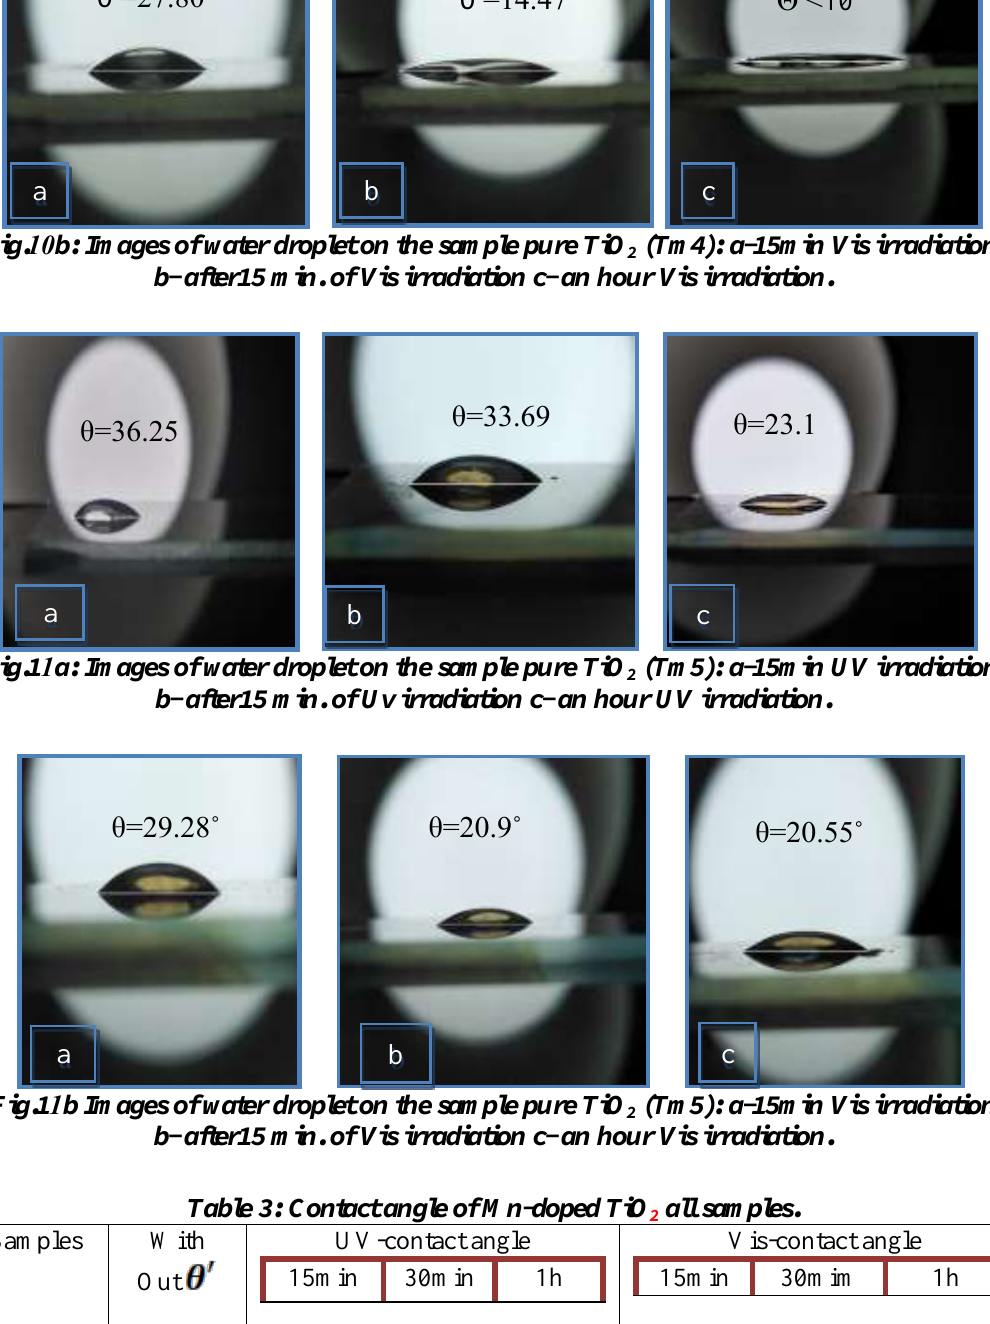
(Tm4): a-15min Vis irradiation, 2